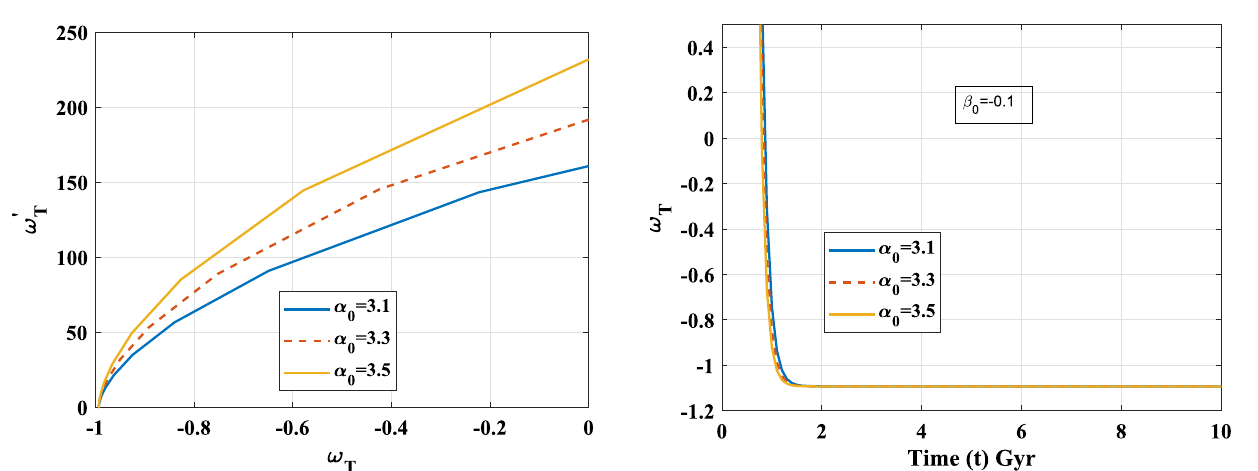
for k = 1 . 9, α 1 = 1 . 2, α 2 = 0 . 52, and T